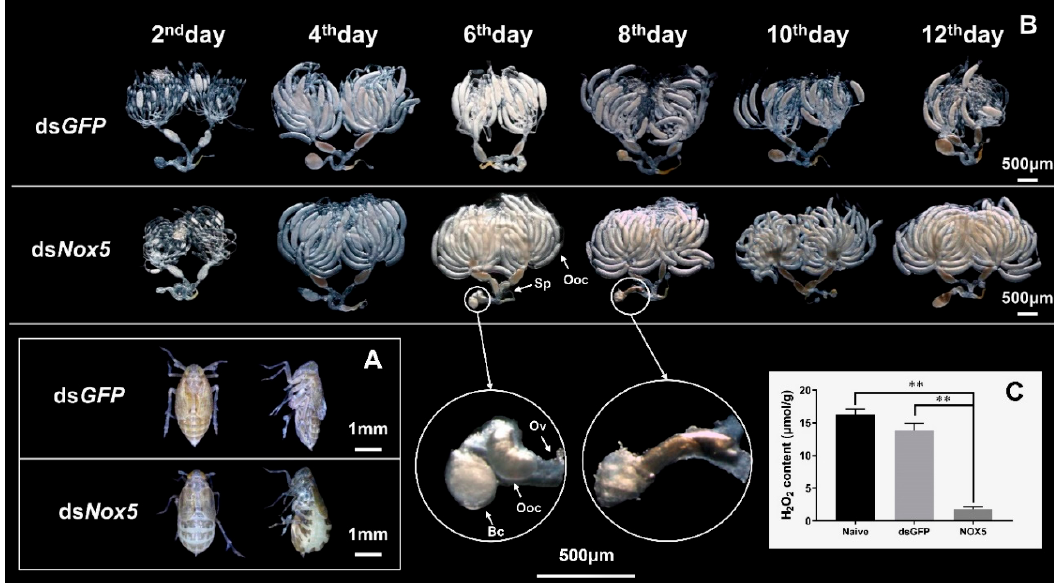
Figure 6. RNAi of Nox5 effects on oocyte formation in female ovaries. ( A ) Observation of the body change in female adults after RNAi. The 5th-instar nymphs were injected with ds Nox5 and the female adults that mated with males at the 10th day were used to observe the body morphology. The left and right images show the back and lateral views of ds GFP - and ds Nox5 -injected females, respectively. ( B ) The ovaries were dissected from the ds Nox5 -treated female adults at the 2nd, 4th, 6th, 8th, 10th and 12th days after mating and were observed under a Leica S8AP0 stereomicroscope. The enlarged circles show the mature oocytes in the lateral oviduct of the female adults. Sp, spermatheca, Ooc, oocyte, Ov, oviduct, Bc, bursa copulatrix. ( C ) The H 2 O 2 content in the ovaries of ds Nox5 -treated female adults at the 8th day after mating was determined by means of a Hydrogen Peroxide Assay Kit (Beyotime Biotech, Shanghai, China). Naive and ds GFP -treated insects were used as controls.